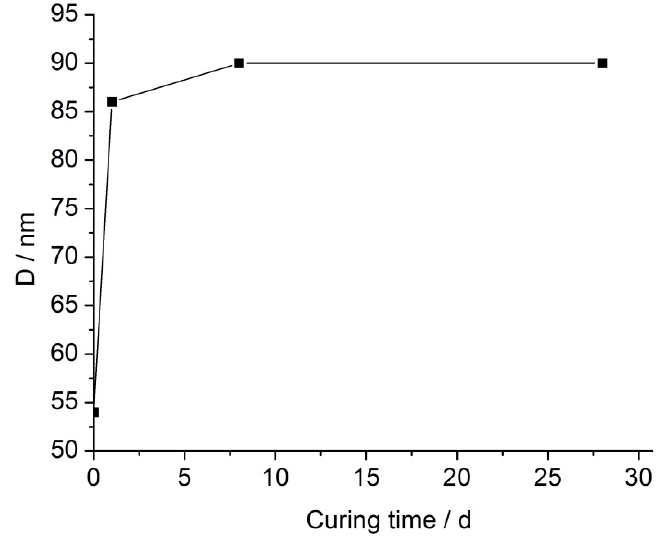
Figure 9. Variation of the CaSO 4 · 2H 2 O crystallite size in terms of curing time for the binder prepared using the (50% NC + 50% gypsum) mixture milled for 270 s and cured at relative humidity of 60–70% at 20–22 °C.